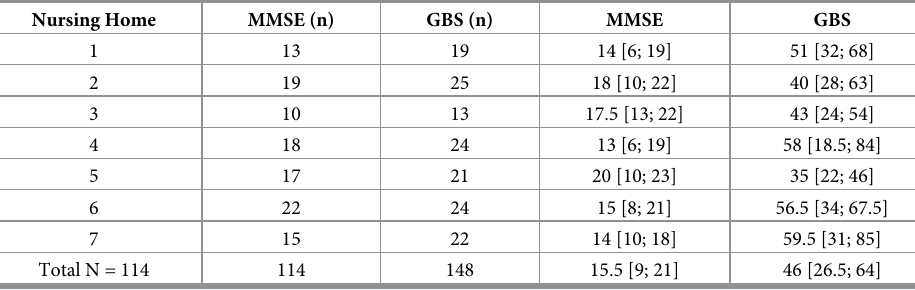
Table 4. Psychiatric measures before the six-week intervention